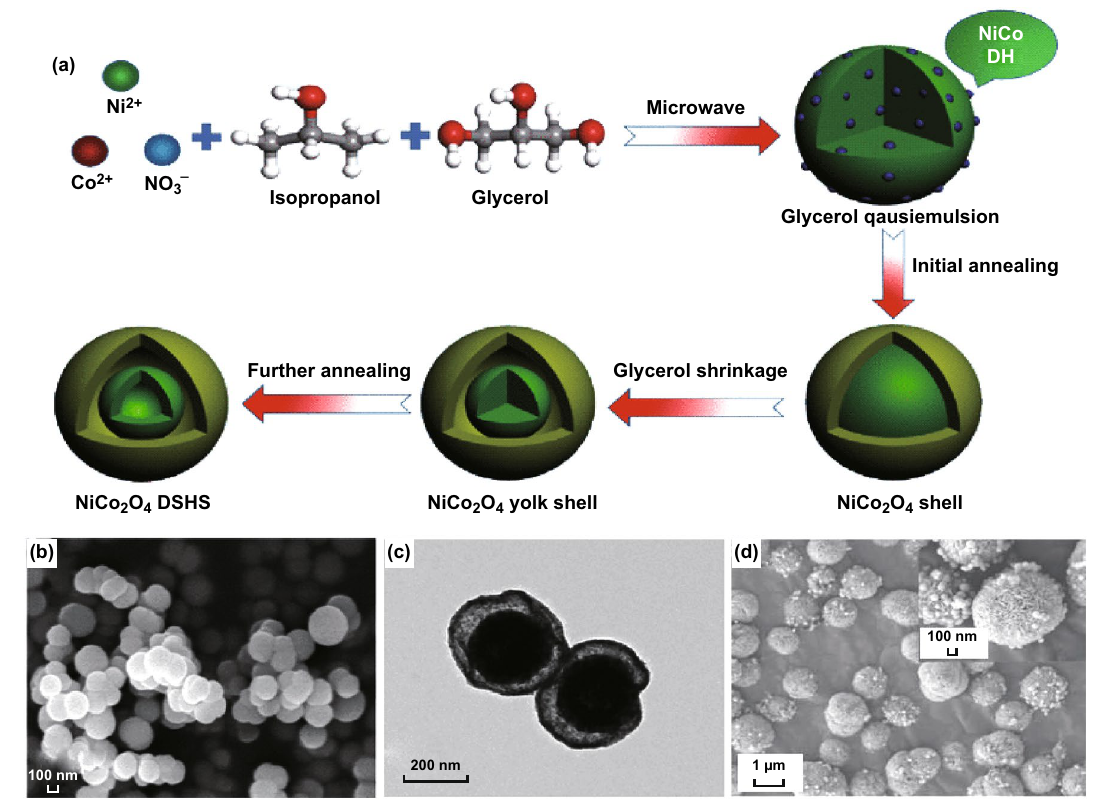
Fig. 19 a Pictorial representation of the microwave-assisted hydrothermal synthesis of NiCo 2 O 4 double-shelled hollow spheres. b FESEM and c TEM images of NiCo 2 O 4 hollow spheres prepared in the presence of glycerol and d FESEM image of the NiCo 2 O 4 structures prepared in the absence of glycerol. Reproduced with permission from Ref. [206]. Copyright © 2017 Springer